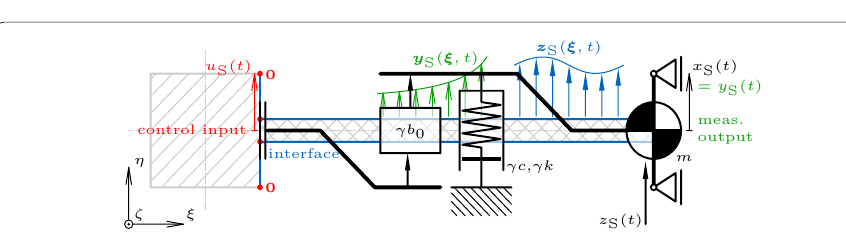
Fig. 8 Computational structural mechanics: low fidelity CSM model for the controller